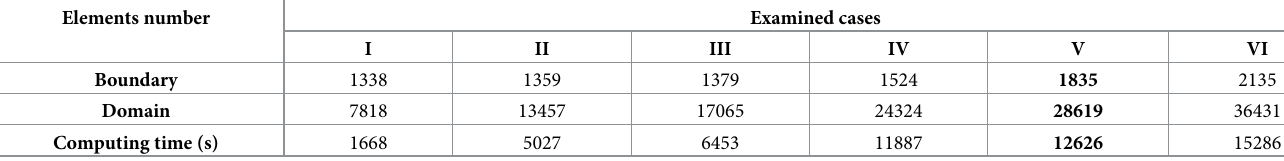
= 0.6 r , A = 0.15 r , Λ = 5, and η = π d s s